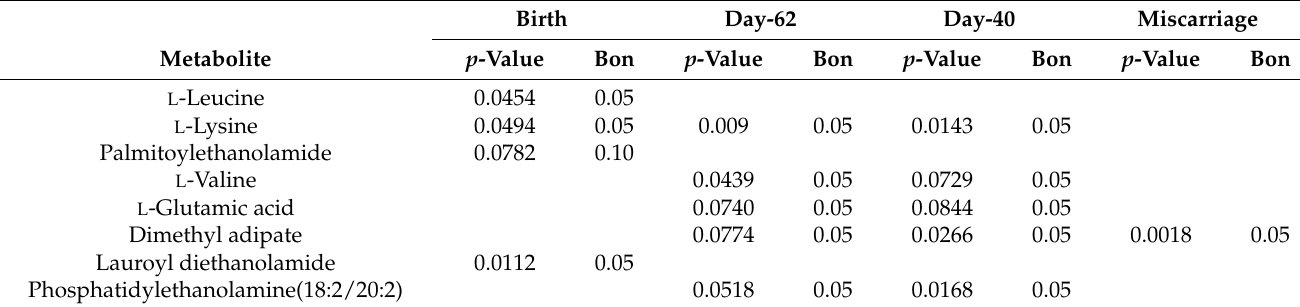
Table 2. Probability of changes in relative concentrations of metabolites that differed in culture medium between transferred embryos later diagnosed as pregnant or open at Day-40, Day-62 and birth, and between embryos that miscarried after Day-40 vs. embryos that never reached pregnancy and vs. embryos that reached pregnancy to term.